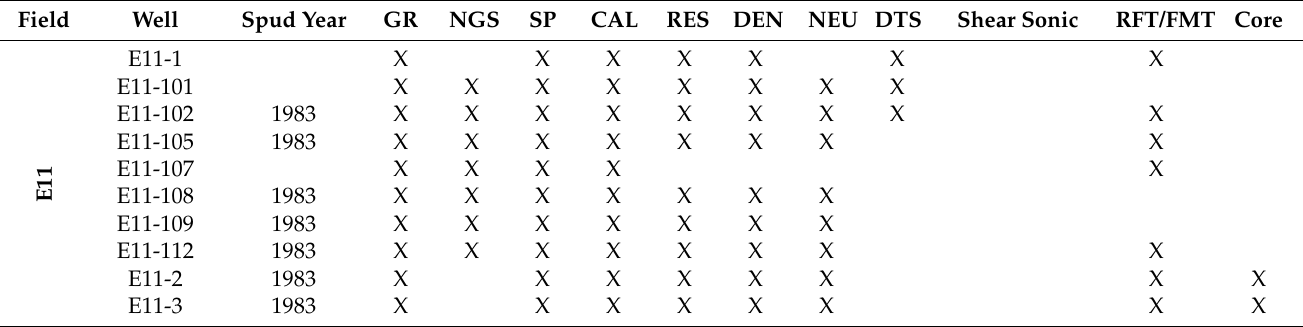
Table 1. Available data from the exploration and development wells in the E11 carbonate field (In X the available data).